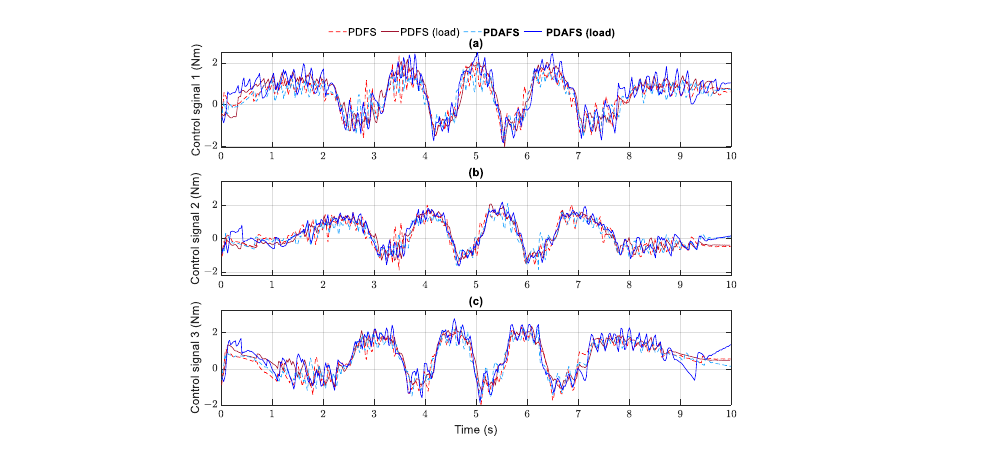
Figure 18. Control signals generated by the PDFS and PDAFS in case 2: joint 1 ( a ), joint 2 ( b ), joint 3 ( c ).